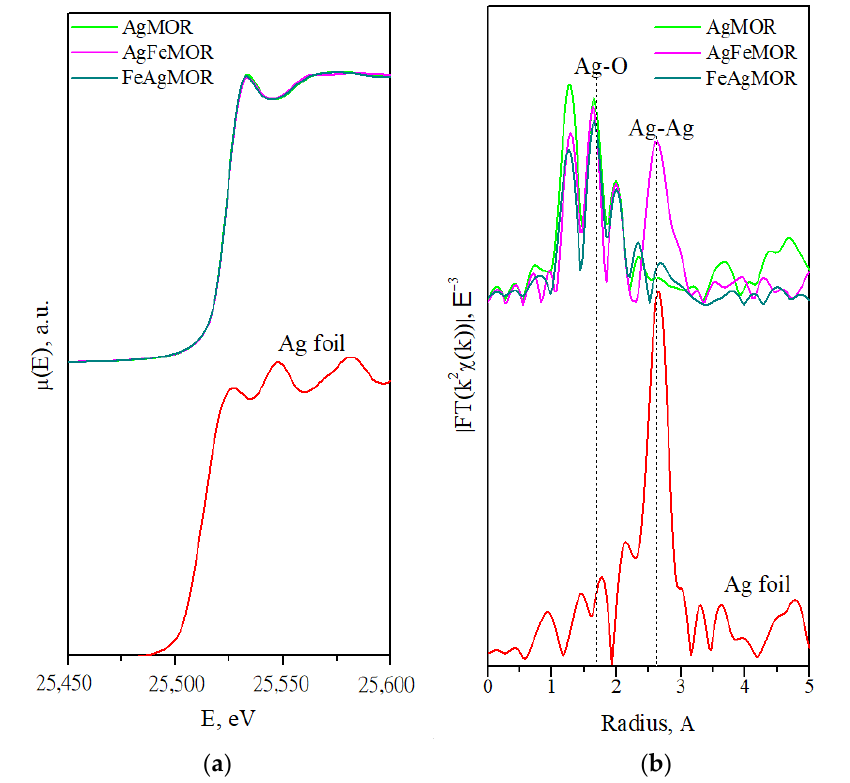
Figure 5. ( a ) Ag K-edge XANES spectra; ( b ) Ag K-edge EXAFS Fourier transforms taken in the k-range from 3 to 15 Å −1 .